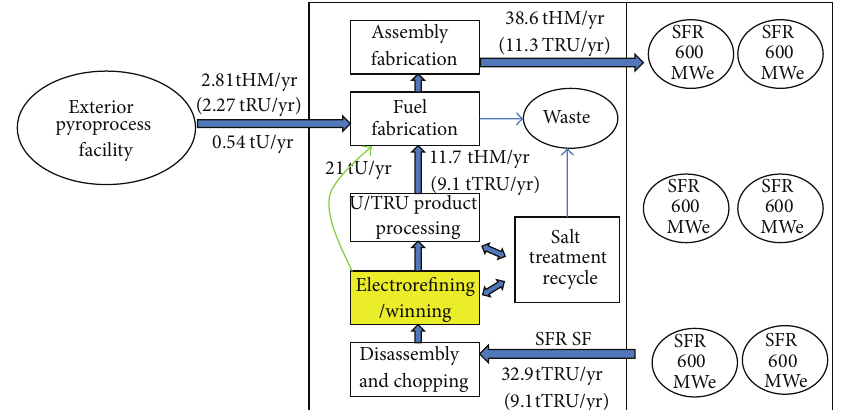
Figure 2: The mass flow diagram of SFR fuel cycle facility.